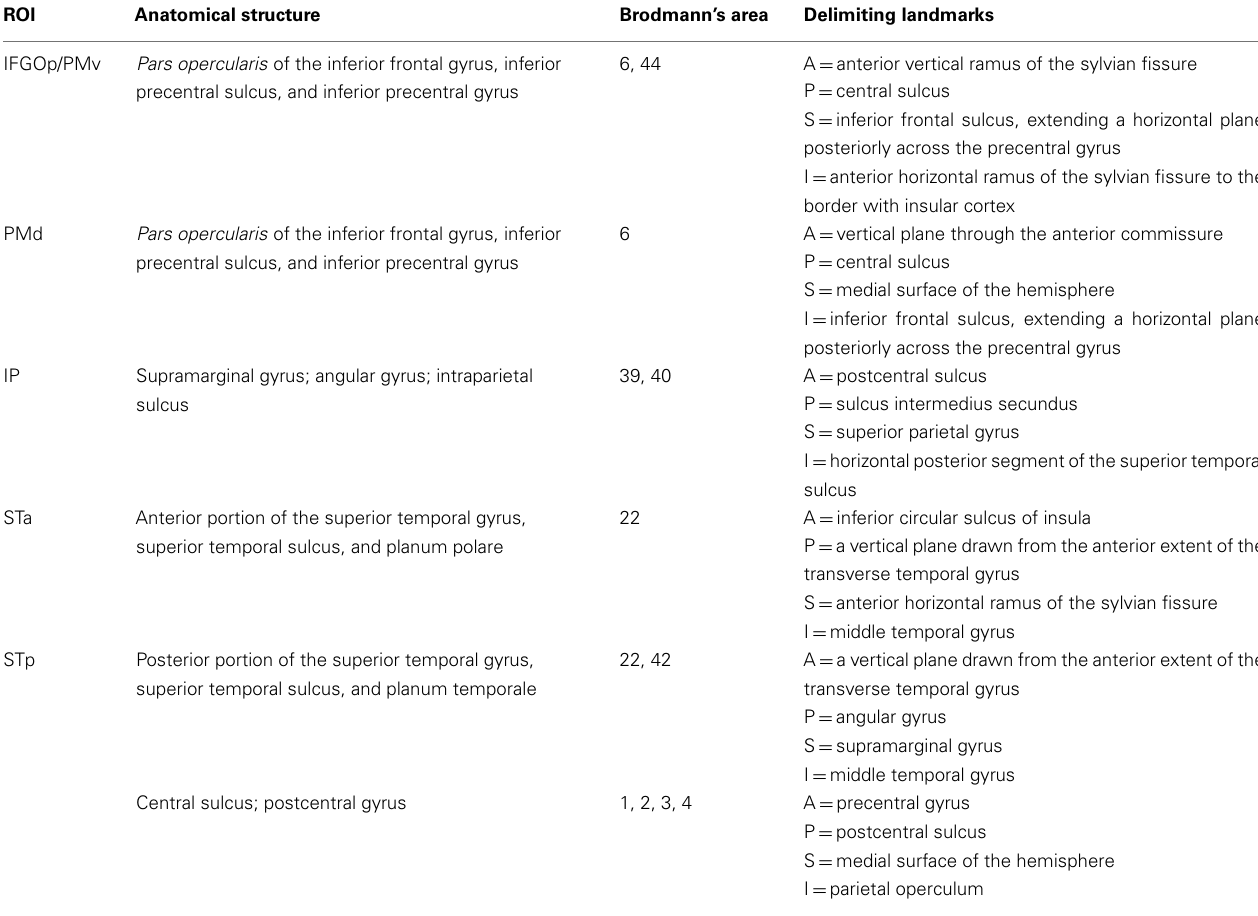
Table 1 |Anatomical description of the cortical regions of interest. ROI Anatomical